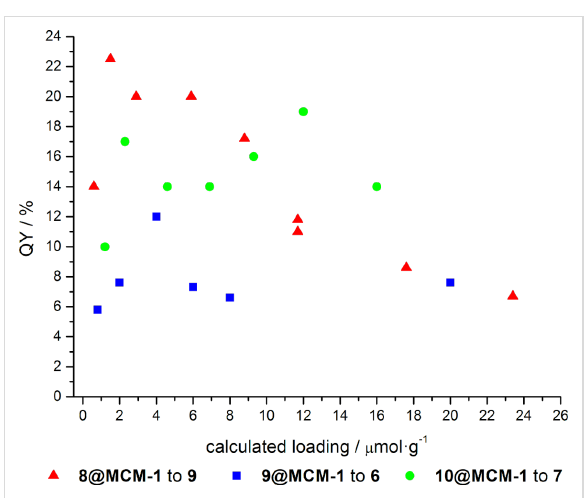
Figure 4: Solid-state fluorescence quantum yields Φ f of grafted hybrid materials in relation to the calculated dye loading ( λ exc ( 9@MCM )